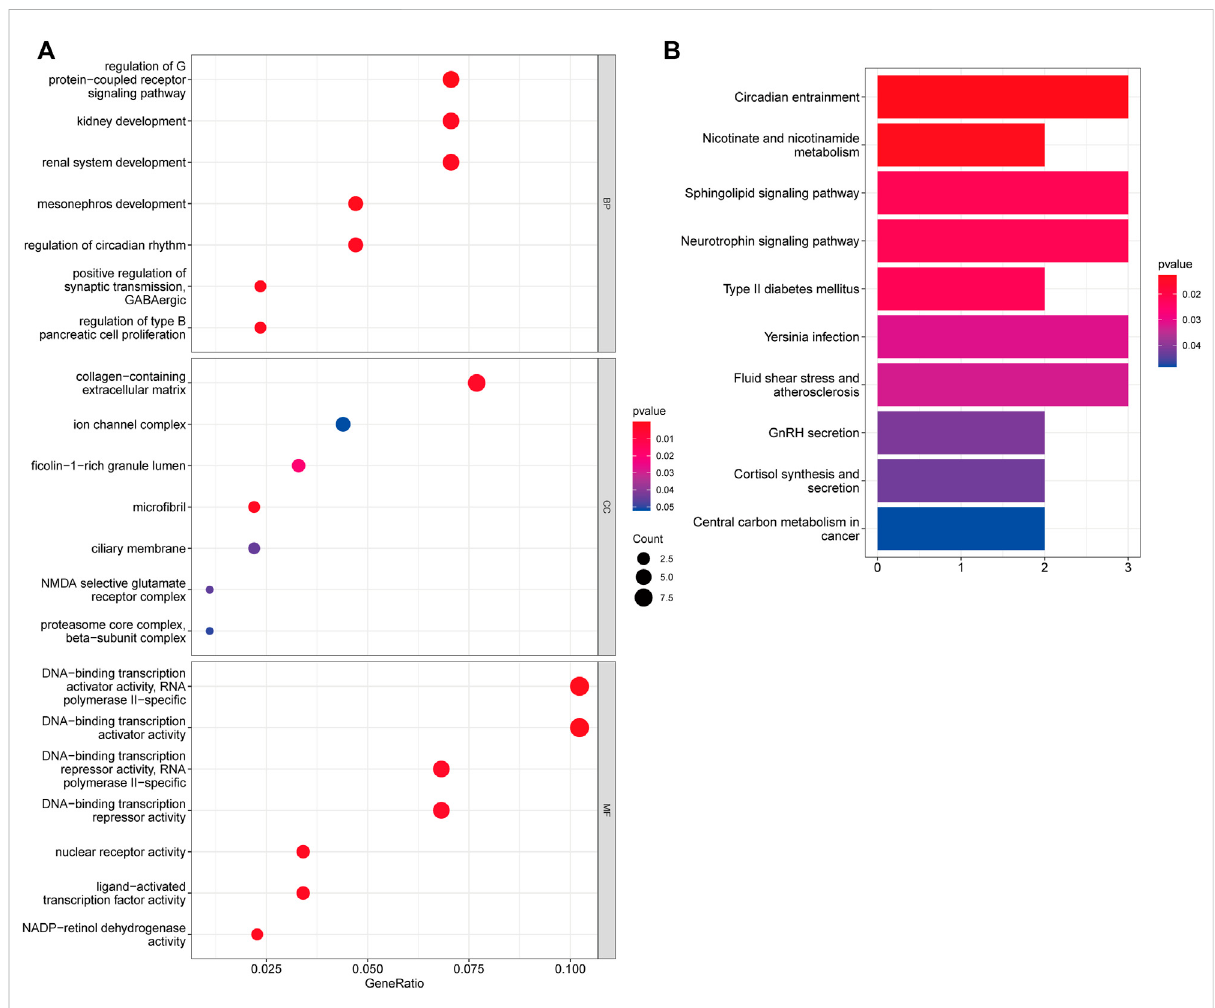
FIGURE 4 Assessments of Functional Enrichment. (A) Bubble plot for Gene Ontology (GO) function enrichment analysis. BP: biological processes; CC: cellular components; MF: molecular function. (B) Bubble plot for Kyoto Encyclopedia of Genes and Genomes (KEGG) pathway enrichment analysis. The y-axis shows pathway terms, whereas the x-axis denotes gene ratio. The size of each circle represents the number of genes. The hue of the circles symbolizes various q